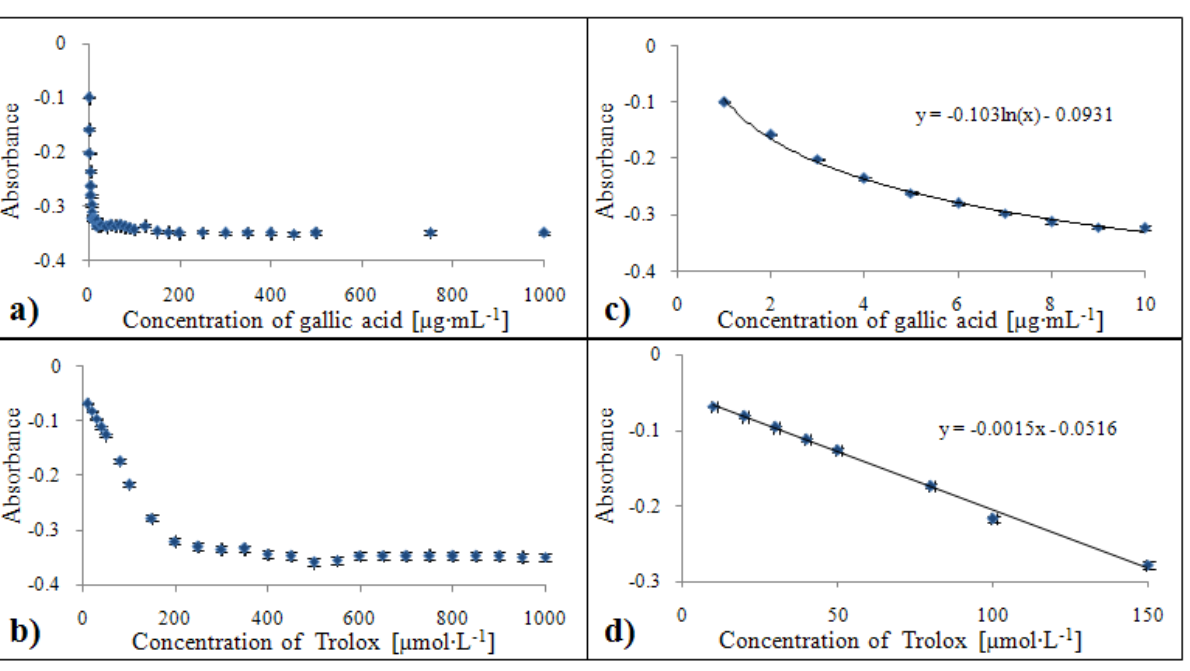
Figure 7. Dependences of absorbance of colour product on concentration of gallic acid (a) and Trolox ® (b) . Calibration curves for DPPH test related to equivalent of gallic acid (c) and Trolox ® (d) expressed as the percentage of